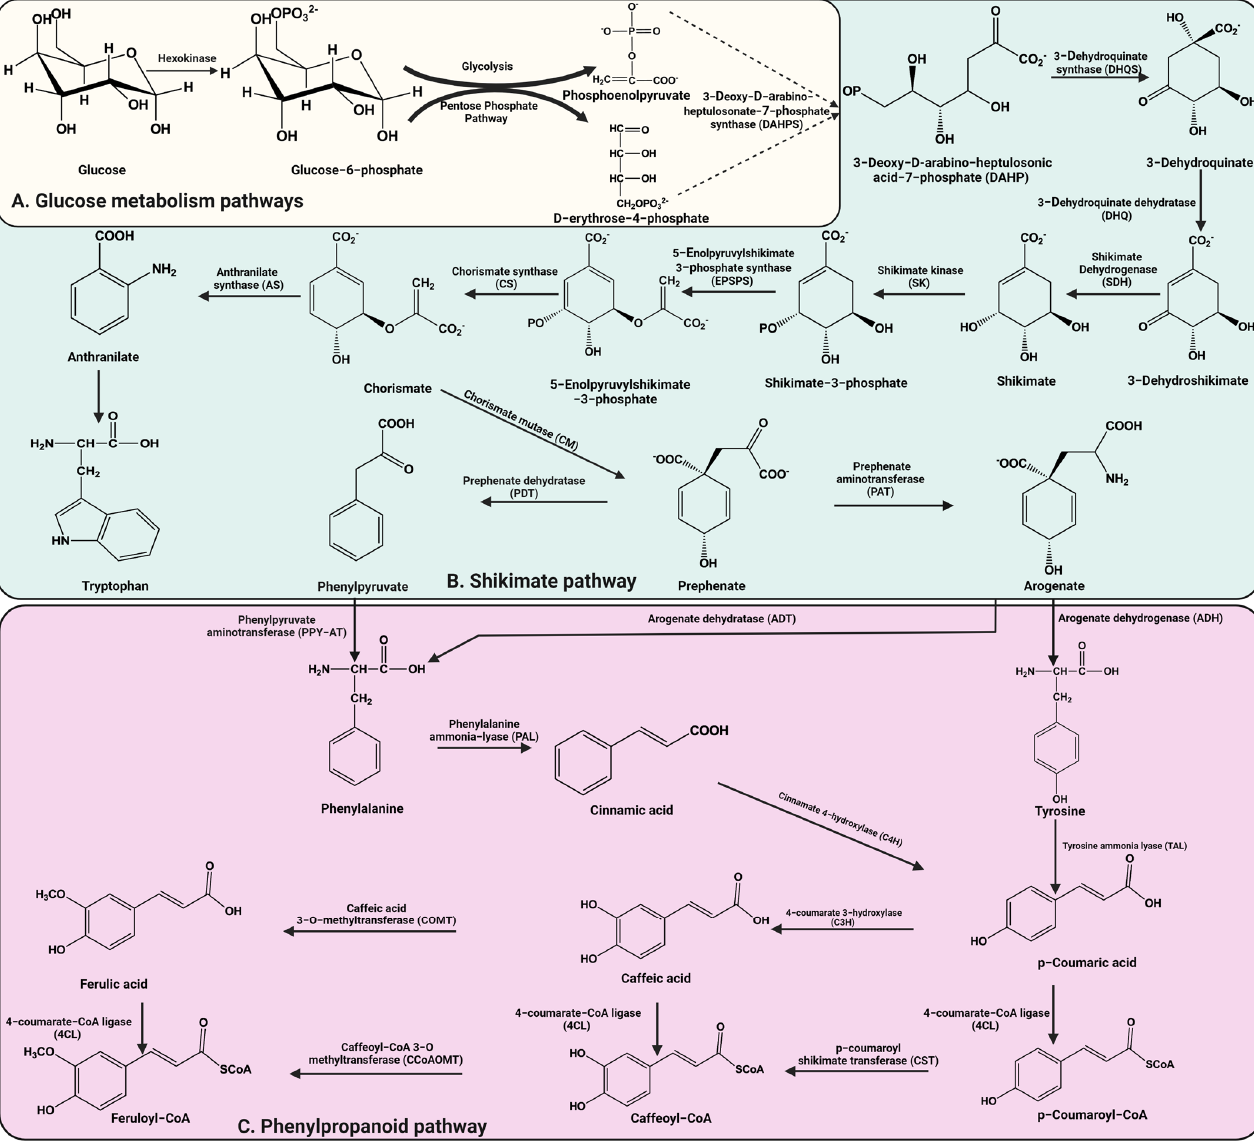
Figure 1. Biosynthesis pathways of polyphenol